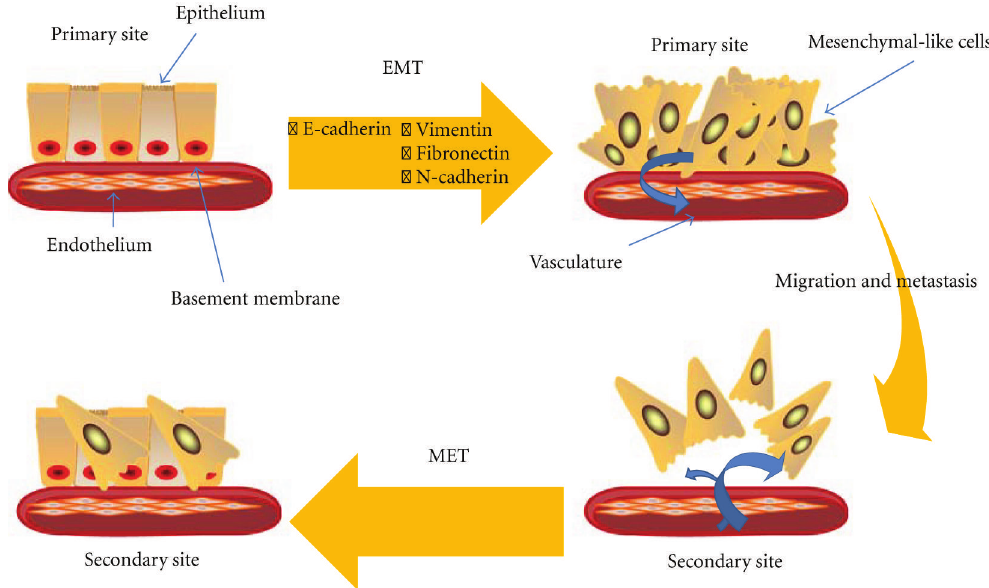
Figure 1: The epithelial-to-mesenchymal transition (EMT) is a physiological process by which an epithelial cell loses polarity and assumes a mesenchymal phenotype. While EMT can occur naturally in gastrulation and wound repair, it is involved as a route of metastasis in cancer. Through molecular changes, such as the loss of E-cadherin, the epithelial cell undergoes remodeling and loosens its attachments from the basement membrane and adjoining cells to enter the vasculature. Once mobile, the malignant cells can take up residence at secondary sites, reverting to an epithelial cell type or remaining